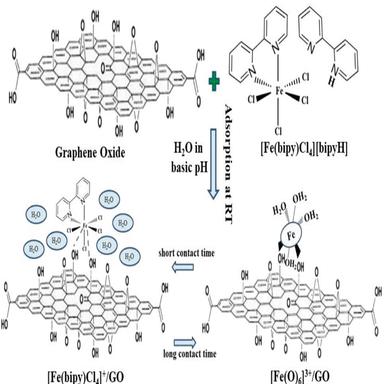
XRD Profiles of Graphite (G), Graphene Oxide (GO), and the Fe-GO Nanocomposite.